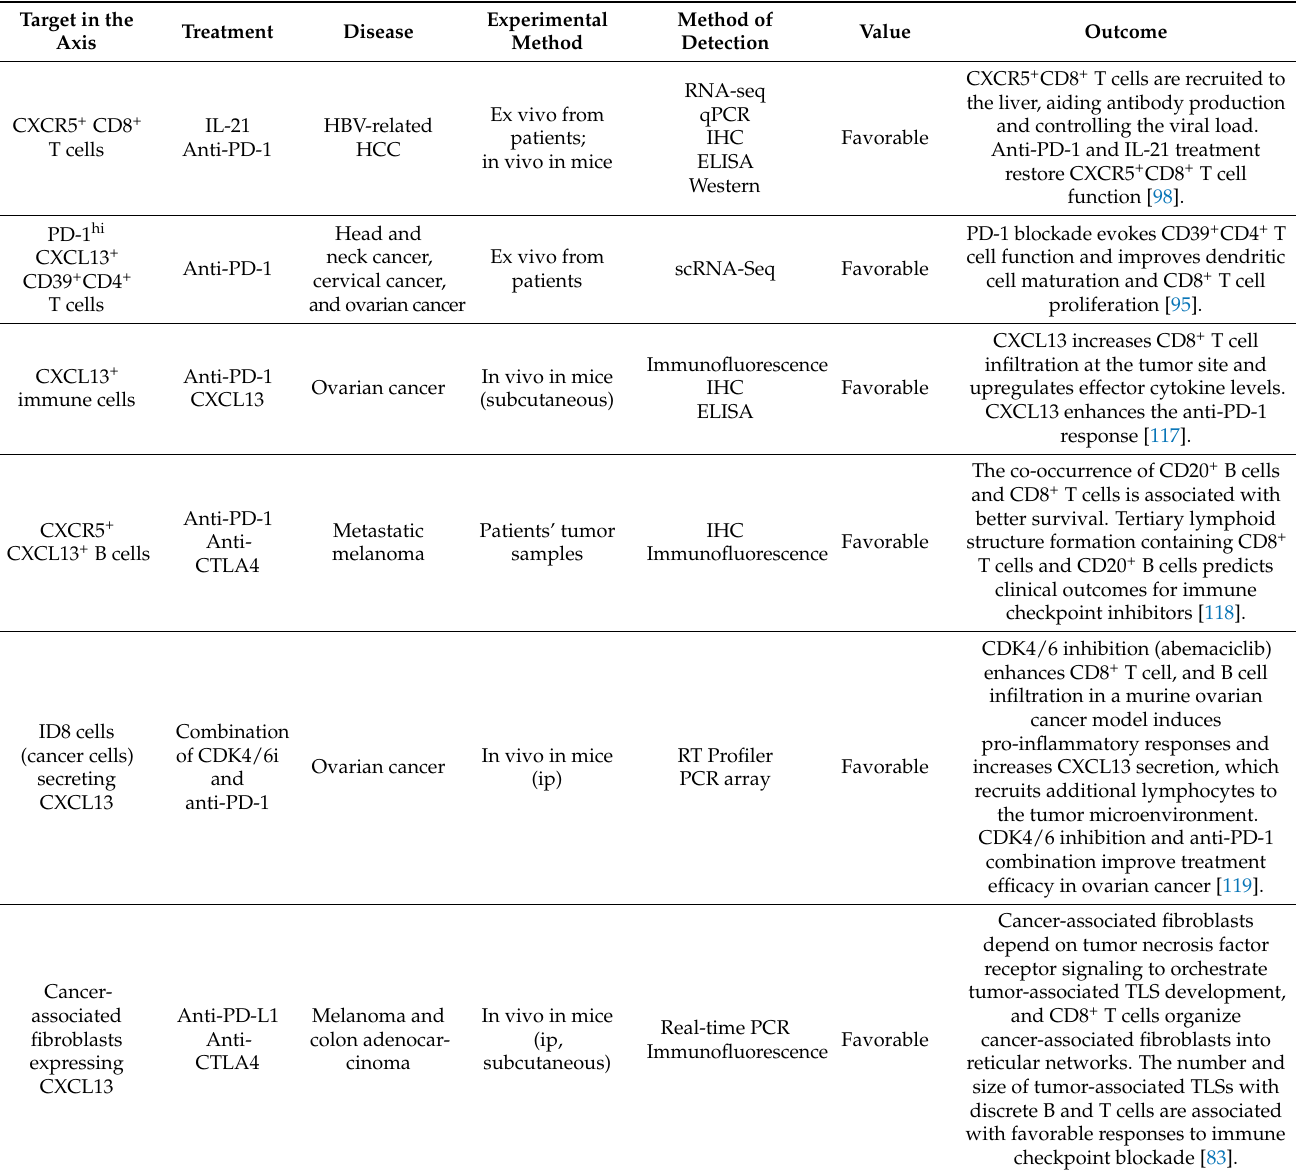
Table 1. Cancer immunotherapy approaches related to the CXCL13/CXCR5 axis, based on preclinical